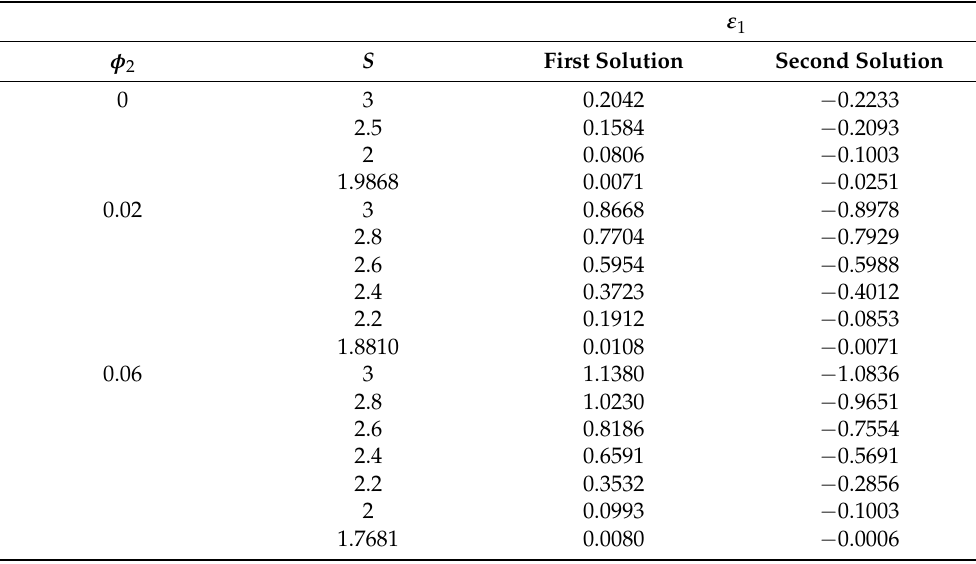
Table 5. The results of the suction parameter S at different values of φ 2 when φ 1 = 0.01, ω =